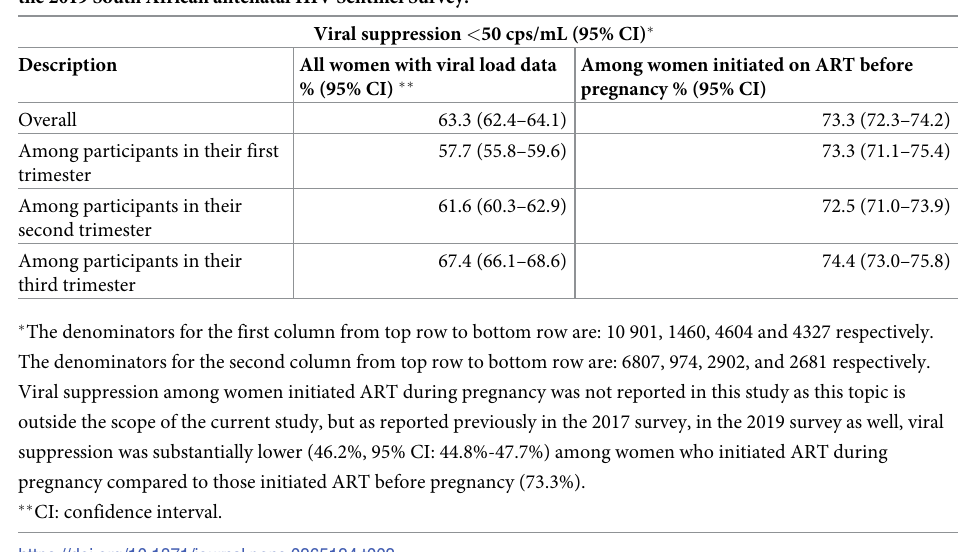
Table 2. Viral suppression of women by gestational age and among women initiated on ART before pregnancy in the 2019 South African antenatal HIV Sentinel